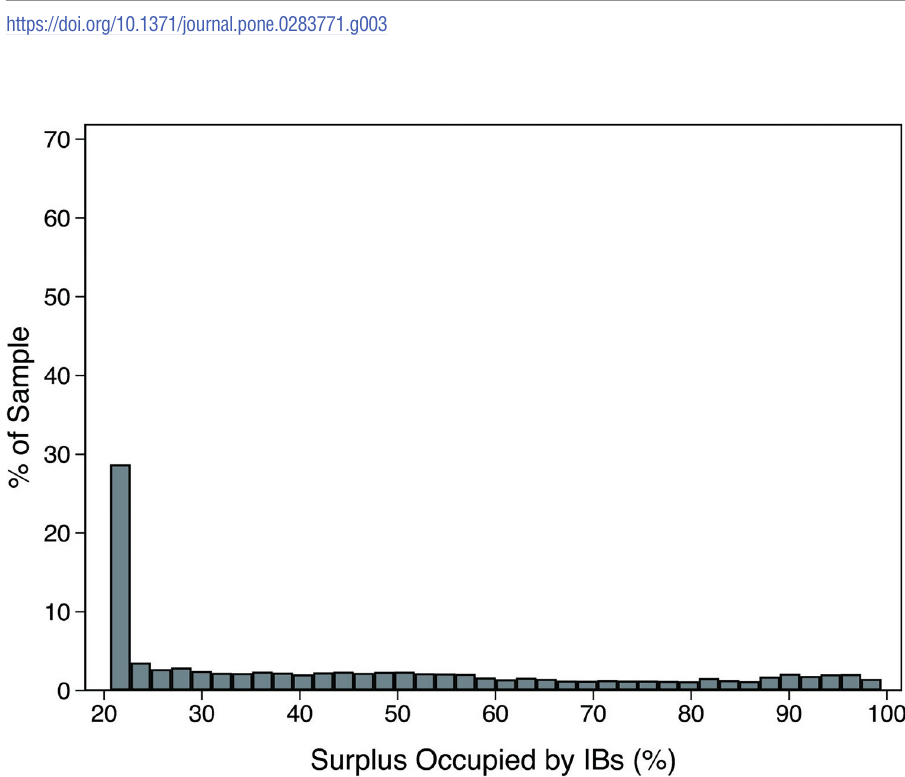
Fig 4. The frequency distribution of the surplus occupied by IBs.